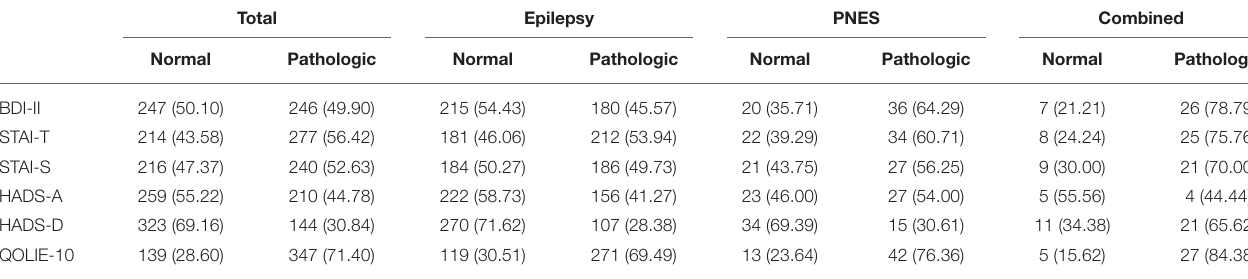
TABLE 4 | Prevalence or frequency of depression, anxiety, and quality of life per diagnostic groups. Total Epilepsy PNES Combined Normal Pathologic Normal Pathologic Normal Pathologic Normal Pathologic BDI-II